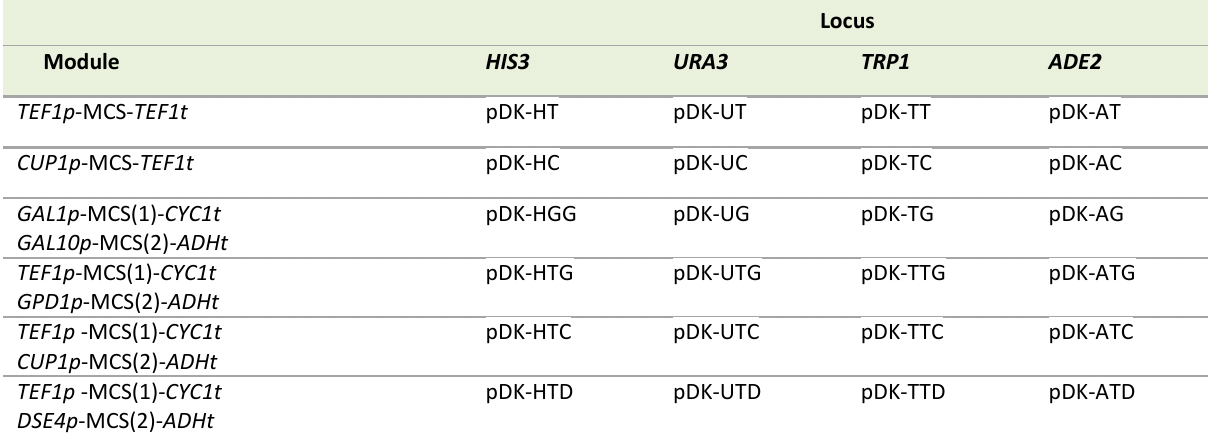
TABLE 1. pDK plasmid series with integrative